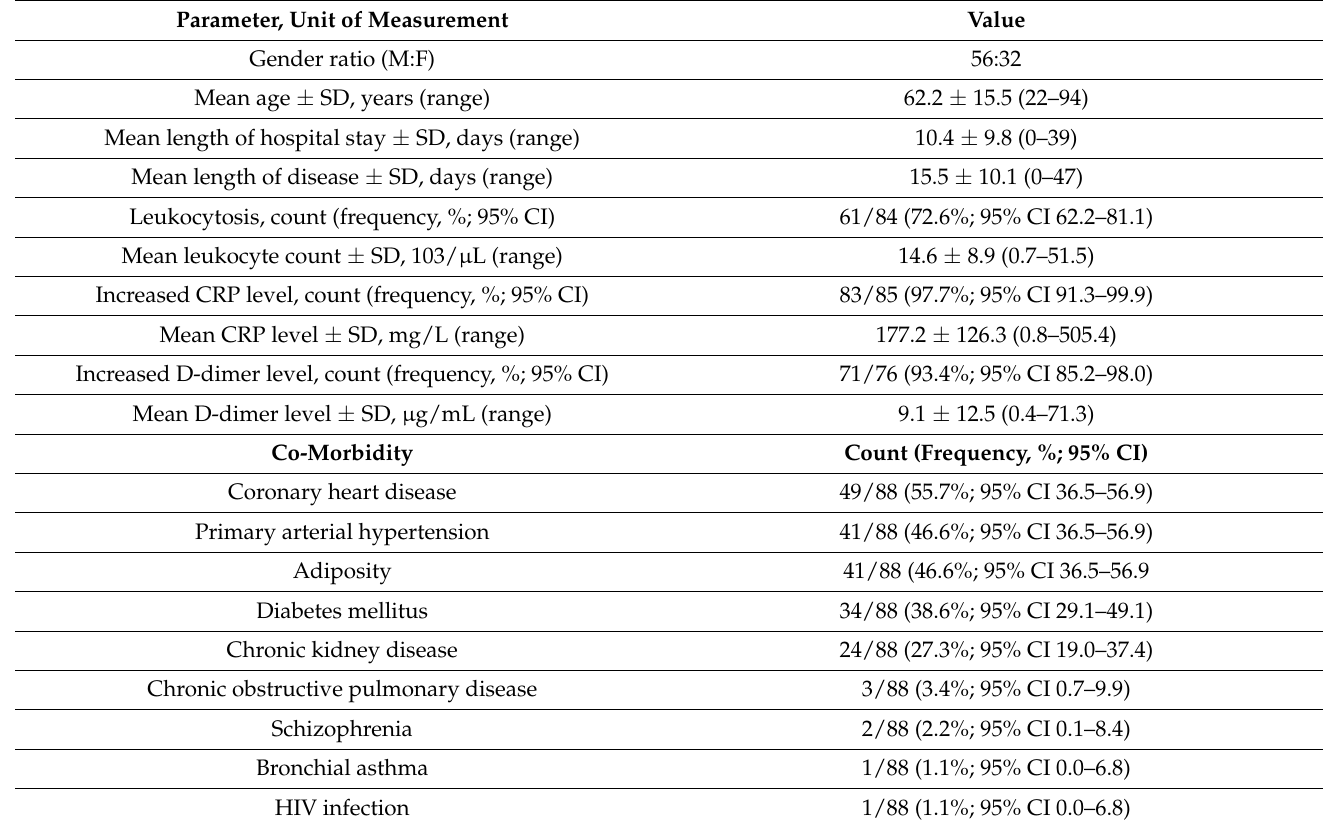
Table 1. Summary of clinical